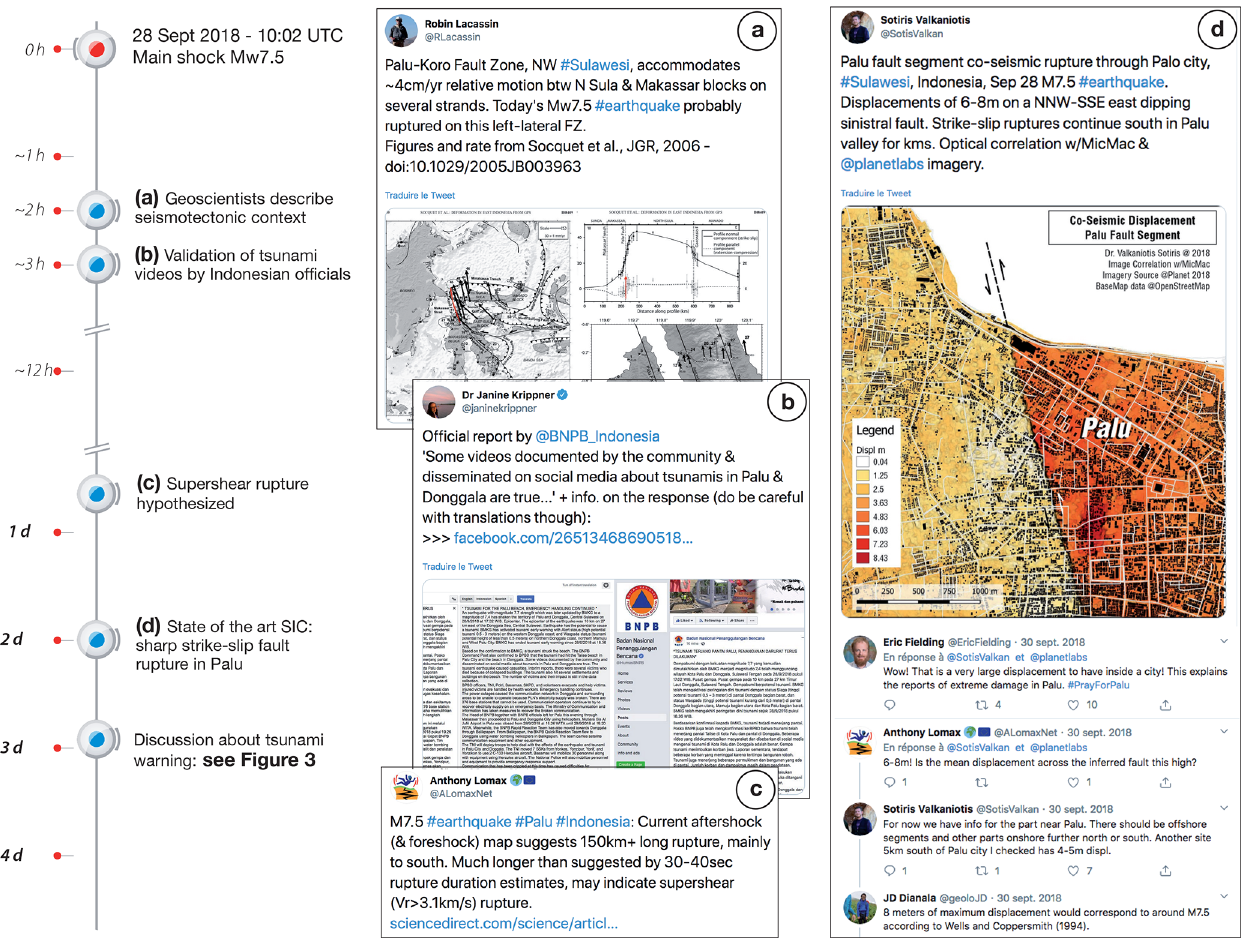
Figure 2. Screenshots of tweets chosen to illustrate how researchers shared and explained observations regarding the Palu earthquake and tsunami of 28 September 2018. A simplified timeline (from Fig. 1) is shown on the left for reference. (a) Within 2h geoscientists described the seismotectonic context of the earthquake. (b) Geoscientists shared and translated the official validation of viral videos about the tsunami in Palu. (c) Researchers hypothesized supershear rupture. (d) Geoscientists shared satellite image correlation results showing a sharp rupture with a 5m left-lateral offset across Palu town, and other researchers started to discuss these results. Refer to Fig. 3 for tweets about the tsunami